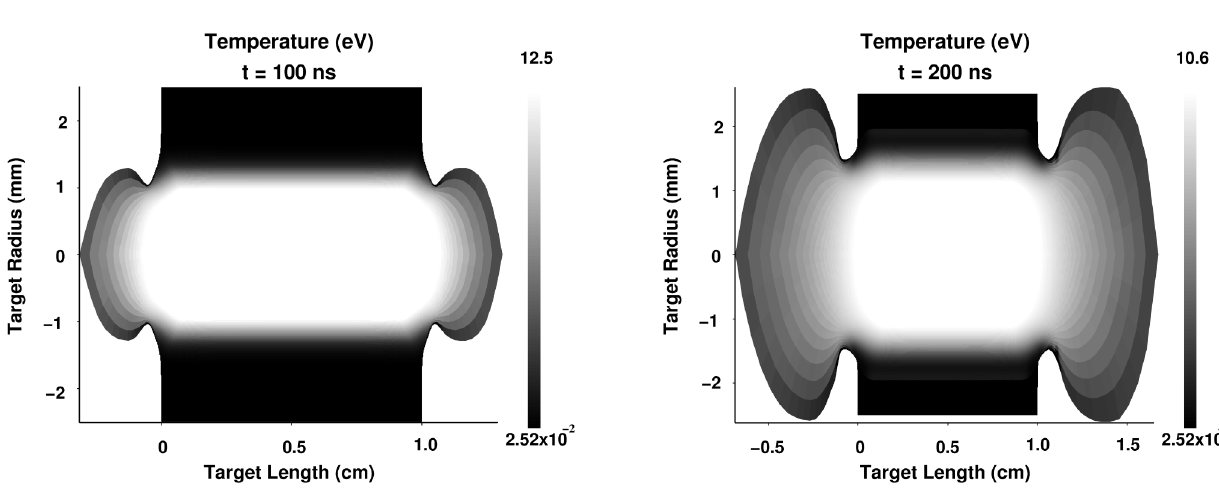
5.FIG. 10. Temperature at t (cid:3) 100 ns corresponding to the case shown in Fig.